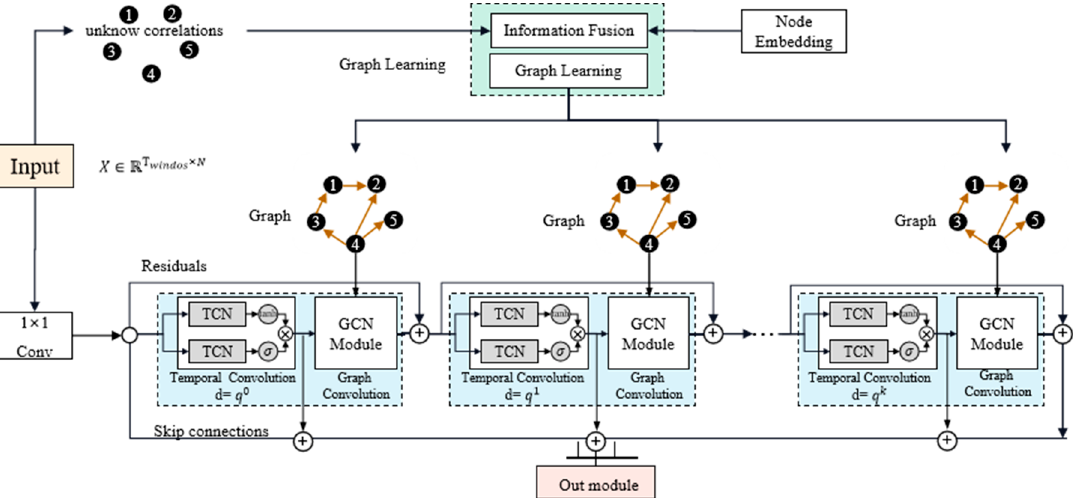
Figure 2. Workflow of AGLCN. First, the input X goes through the graph-learning layers to obtain the graph structure. Then, raw data X and the inferred graphs go through the TCN and GCN for feature transformation. The features extracted by the TCN at each layer are linked to the output module by skipping connections to obtain the prediction results. Finally, the network is jointly optimized via prediction loss and graph regularization. The number 1 (cid:13) – 5 (cid:13) mean the nodes of